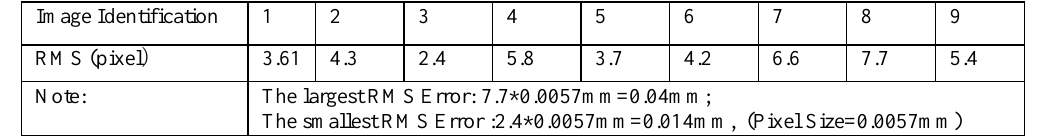
Table 2. The RMS errors of the urban test for 9 UAV images